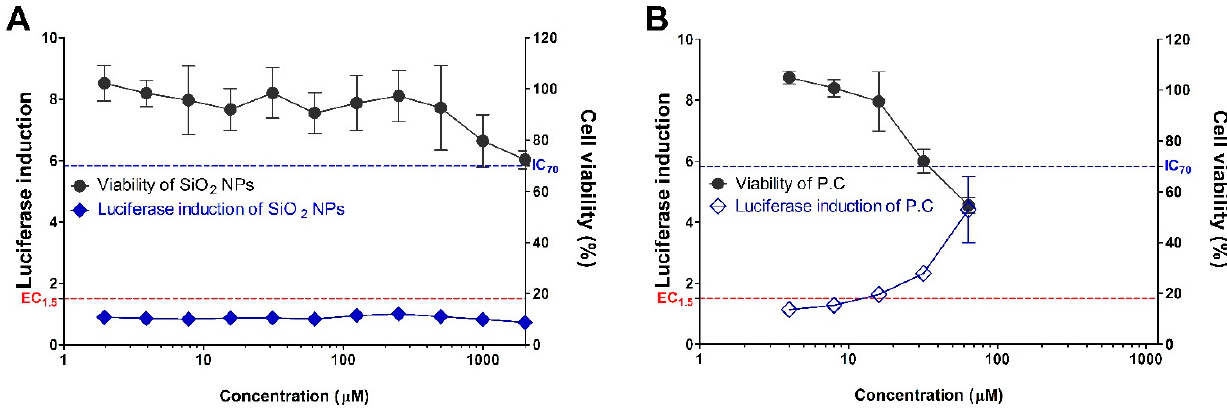
Figure 3. Induction of luciferase activity (blue line) and viability (black line) in the KeratinoSens TM assay. The cells were treated with the ( A ) Silica NP, and ( B ) positive control (cinnamic aldehyde, CAS number 14371-10-9). Data are expressed as mean ± SEM ( n = 6). Positive control was tested in parallel (4–64 μ M).